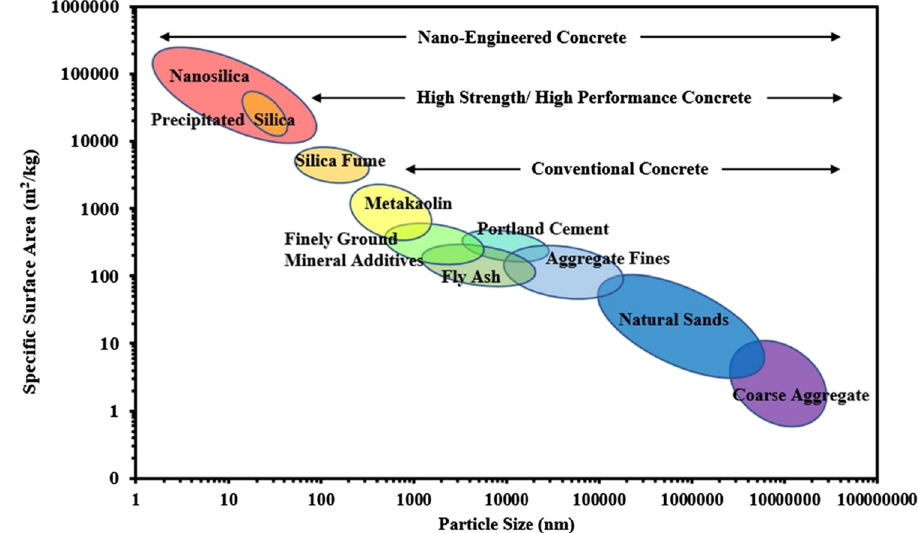
Figure 1: Particle size and speci fi c surface area related to concrete materials [ 20 ]